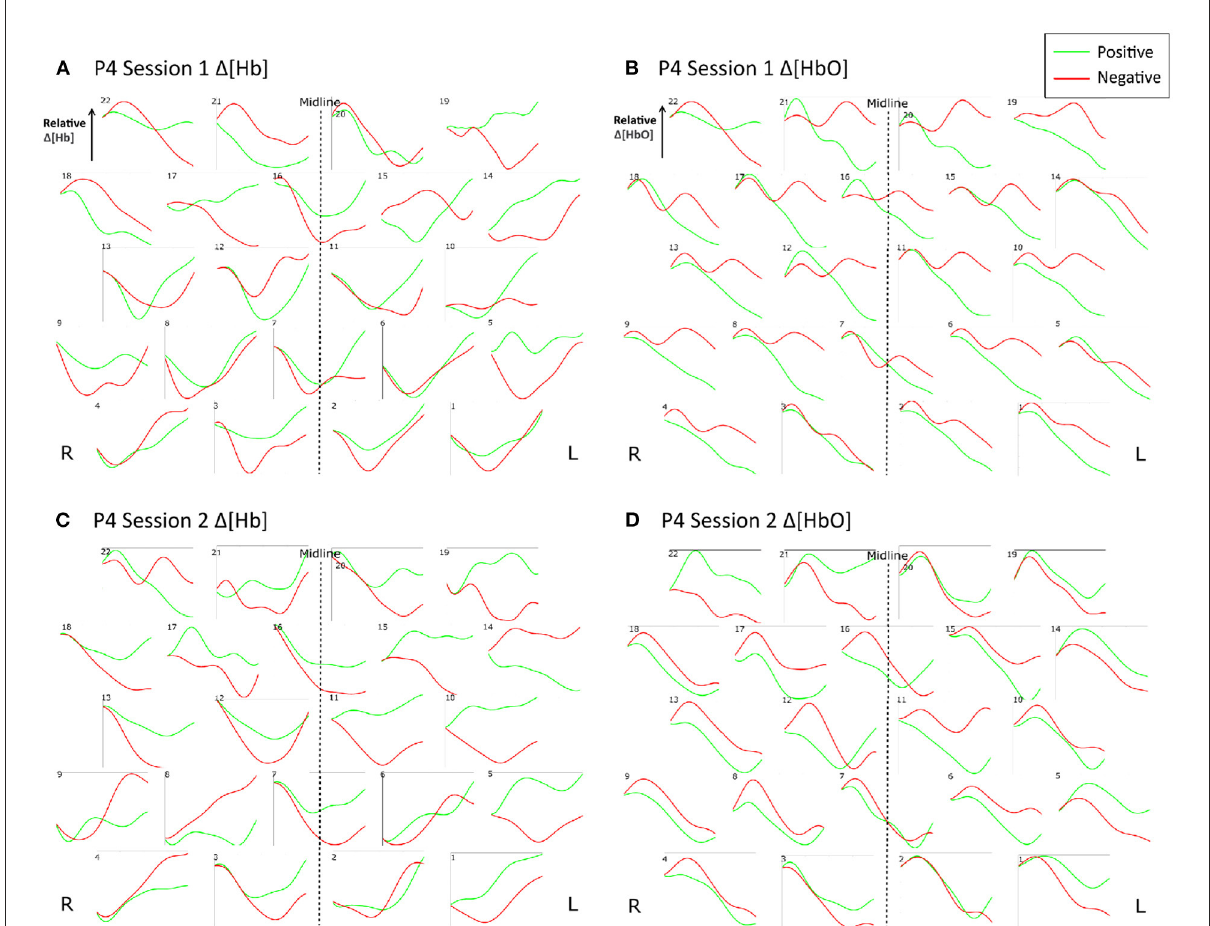
FIGURE9 Trial-averaged hemodynamic response functions ( 1 [HbO] and 1 [Hb]) for P4 for Sessions 1 and 2. (A) 1 [HbO] for Session 1, (B) 1 [HbO] for Session 2, (C) 1 [Hb] for Session 1, and (D) 1 [Hb] for Session 2. The response function for each channel is shown mapped according to its position over the forehead. The lighter shade (green) indicates the average of all positive trials, and the darker shade (red) indicates the average of all negative trials from the respective